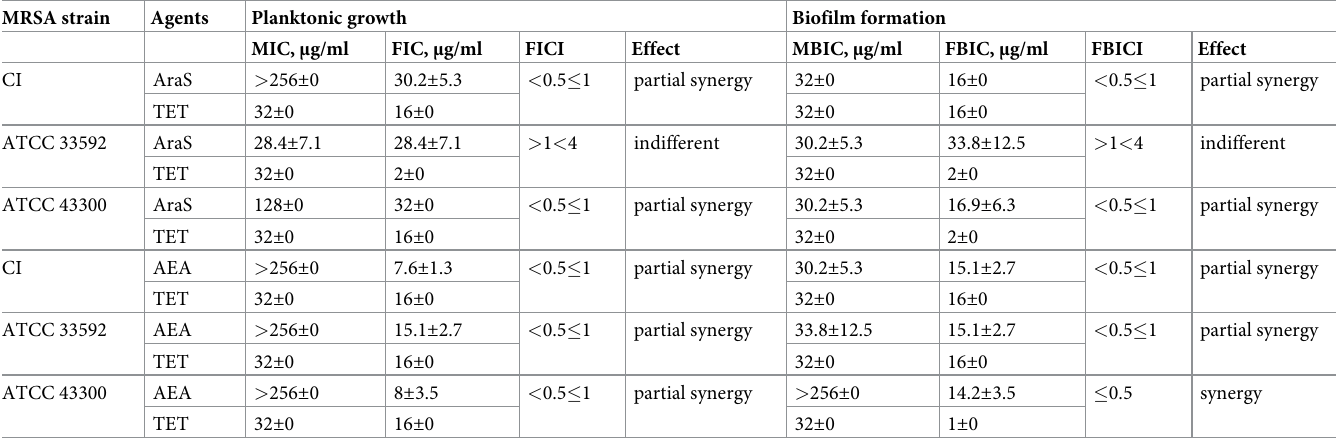
Table 4. Effects of the combinations of AraS/AEA with TET against MRSA strains.